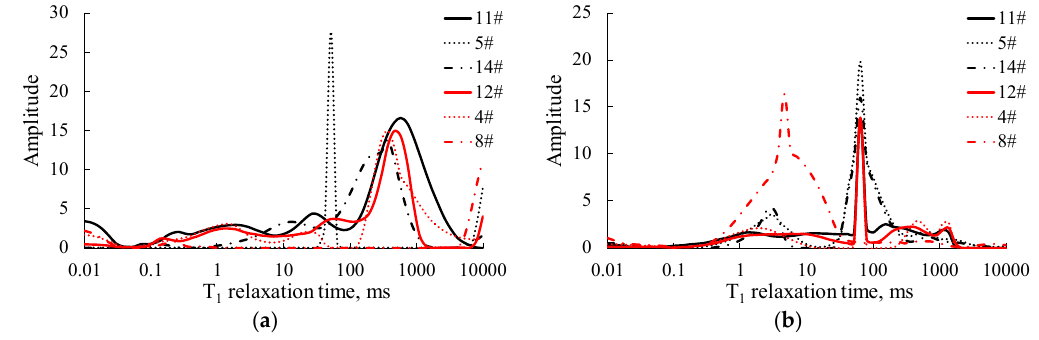
Figure 9. NMR T 1 distributions of specimens ( a ) before and ( b ) after centrifugations.